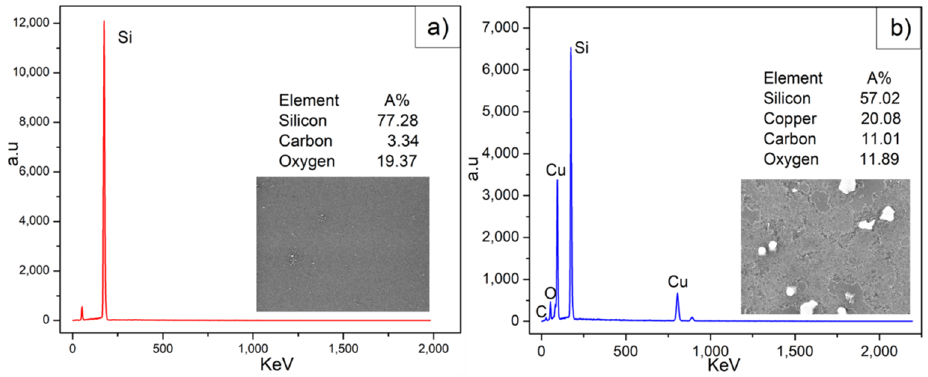
Figure 6. EDS spectrum of graphene on SiO 2 /Si substrate ( a ) and ( b ) shows the EDS spectrum next to and on top of the copper-strip, respectively.